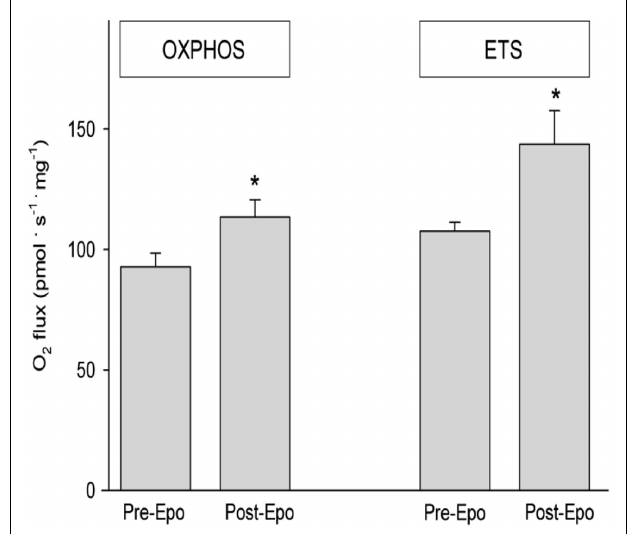
FIGURE 2 | Mitochondrial respiration measured by high-resolution respirometry in permeabilized fibers from the vastus lateralis before and after Epo treatment. OXPHOS; state 3 respiration for Complex I + II before and after rhEpo. ETS; Maximal ElectronTransfer System assessed adding FCCP before and after rhEPO treatment. Data are means ± SEM. Asterisk ∗ indicates significant difference pre vs. post, p <